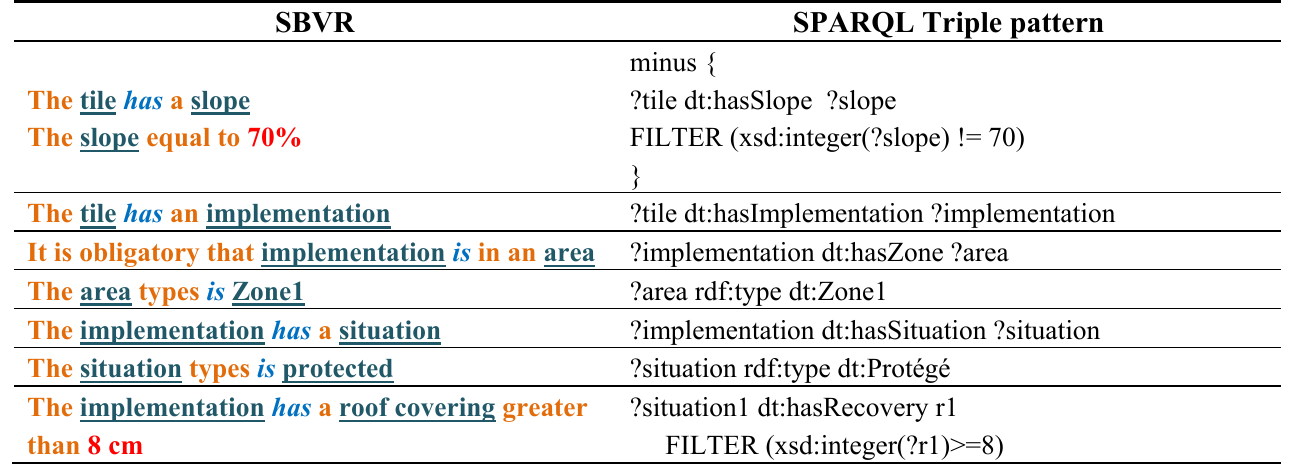
Figure 6. SPARQL query of the antecedent (Example